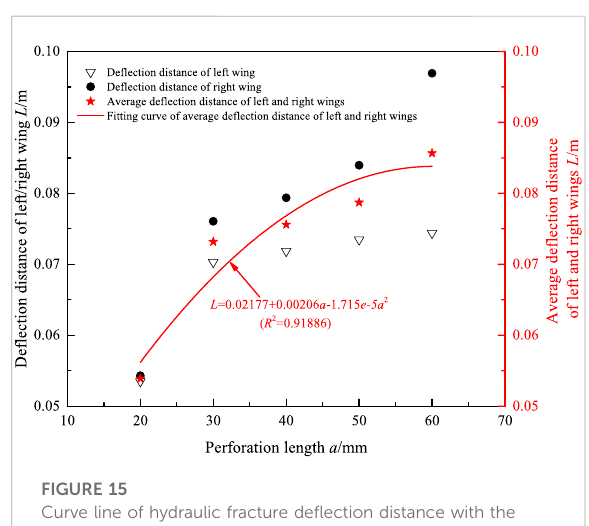
FIGURE 14 Fracture de fl ection trajectory with the change of perforation length.